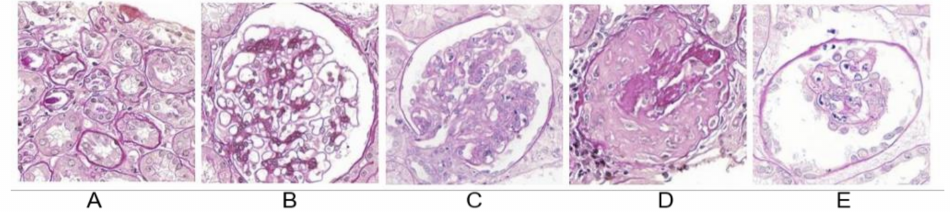
Figure 3. Examples of correct classification. ( A ) Regions in which the localisation module is incor- rectly located (non-glomerular area). ( B ) Glomerulus with slight lesions. ( C ) Glomerulus with severe lesions. ( D ) Sclerotic glomerulus. ( E ) Incomplete glomerulus, which can be due to cutting artefacts.